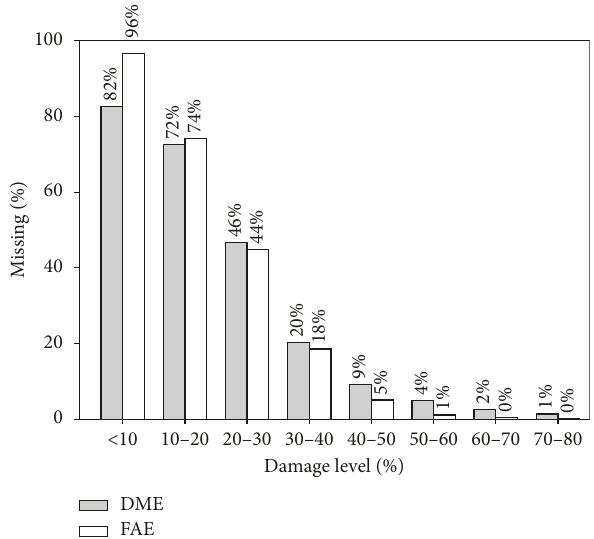
Figure 27: MLP’s DME and FAE versus damage level for the structural beam using MLP